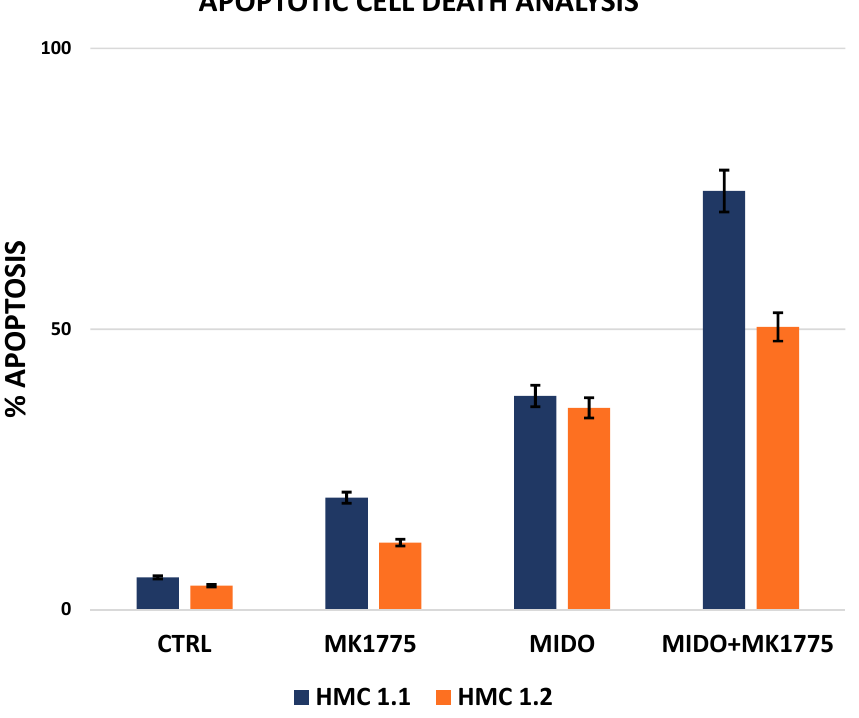
Figure 4. Effects of WEE1 or KIT inhibition alone or in combination. Flow cytometry analysis of apoptosis induction in HMC-1.1 ( blue ) and HMC-1.2 ( orange ) cells following 24 h treatment with MK1775 or midostaurin (1 µ M) alone or in combination. Columns represent the mean of three independent experiments and the bars represent the standard error. ctrl,